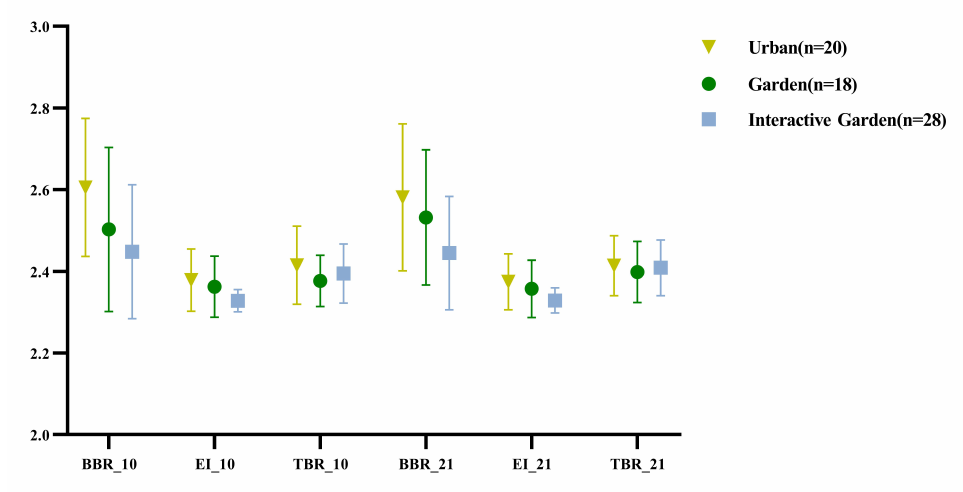
Figure 13. Descriptive statistical results of the change of PSD in different frequency